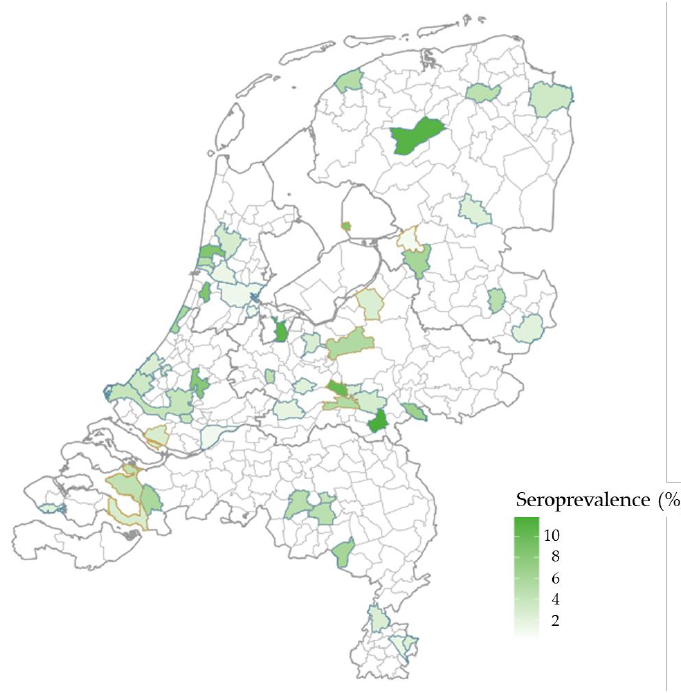
Figure 3. Lyme borreliosis seropositivity in the sampled municipalities in The Netherlands. Blue and orange boundaries indicate municipalities in the national sample and low vaccination coverage sample, respectively.